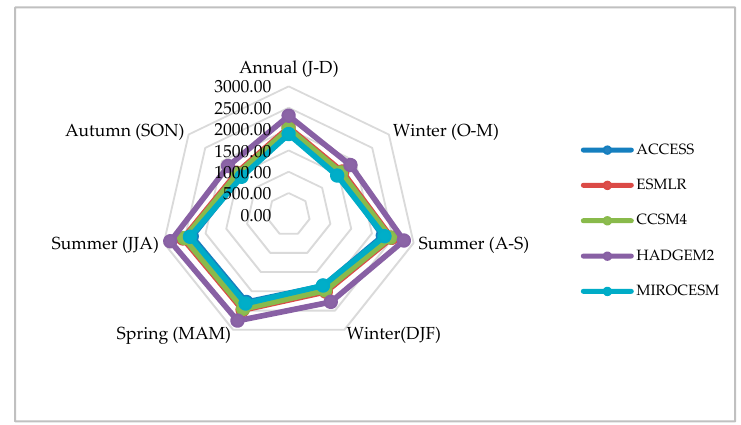
Figure 14. Average annual and seasonal flows for the period 2021–2100 under distribution mapping downscaling technique.